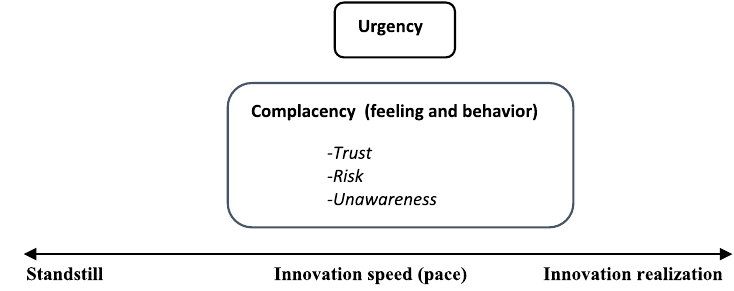
Fig. 1 Conceptual model: innovation speed line with contributing factors for innovation